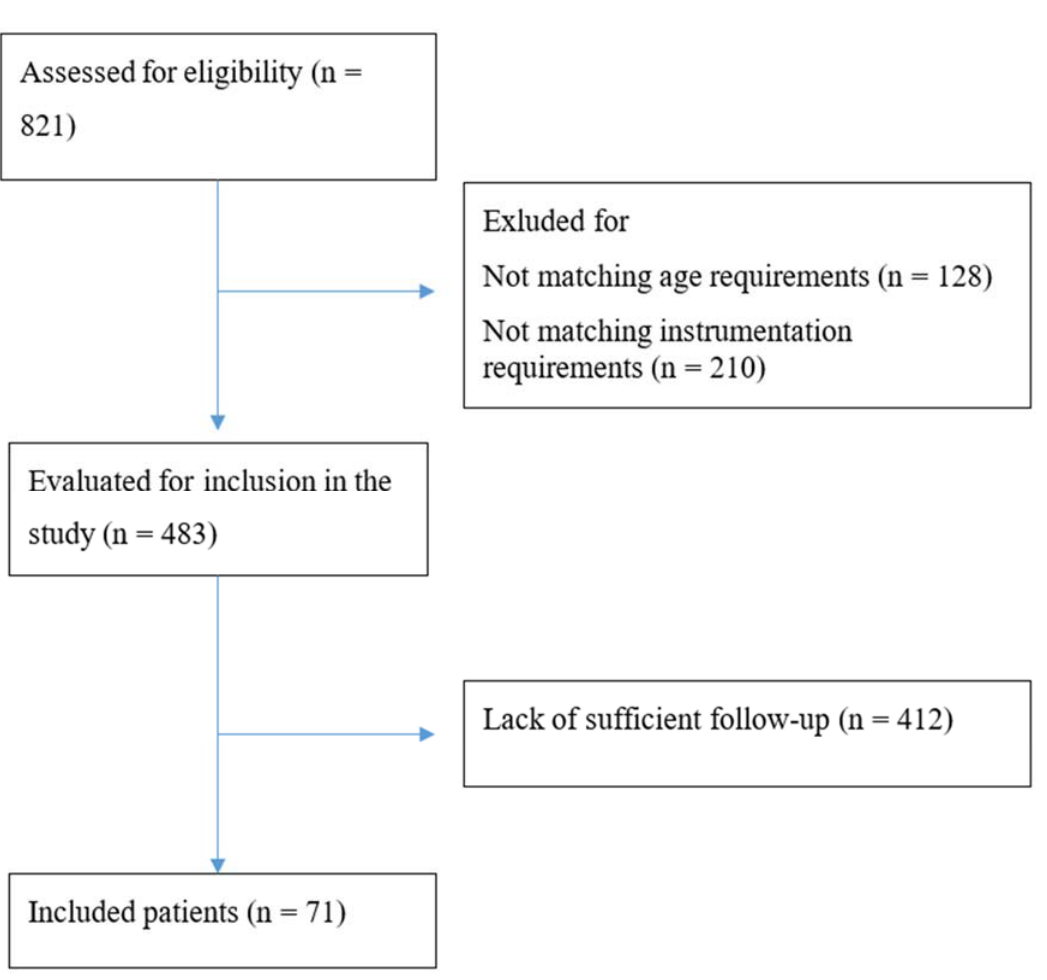
Figure 1. STROBE flow diagram of patient selection.